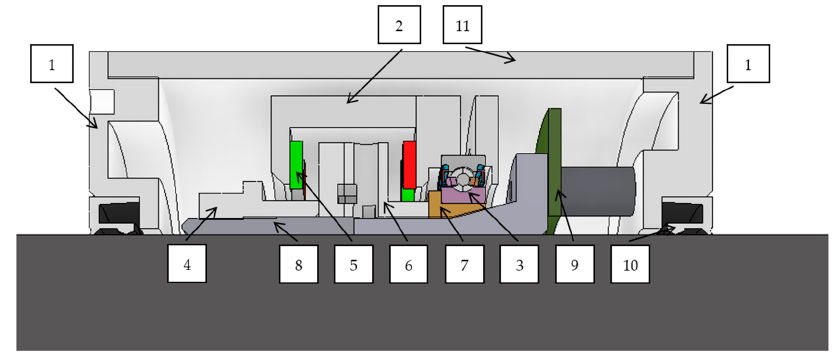
Figure 3. Sectional view of the energy